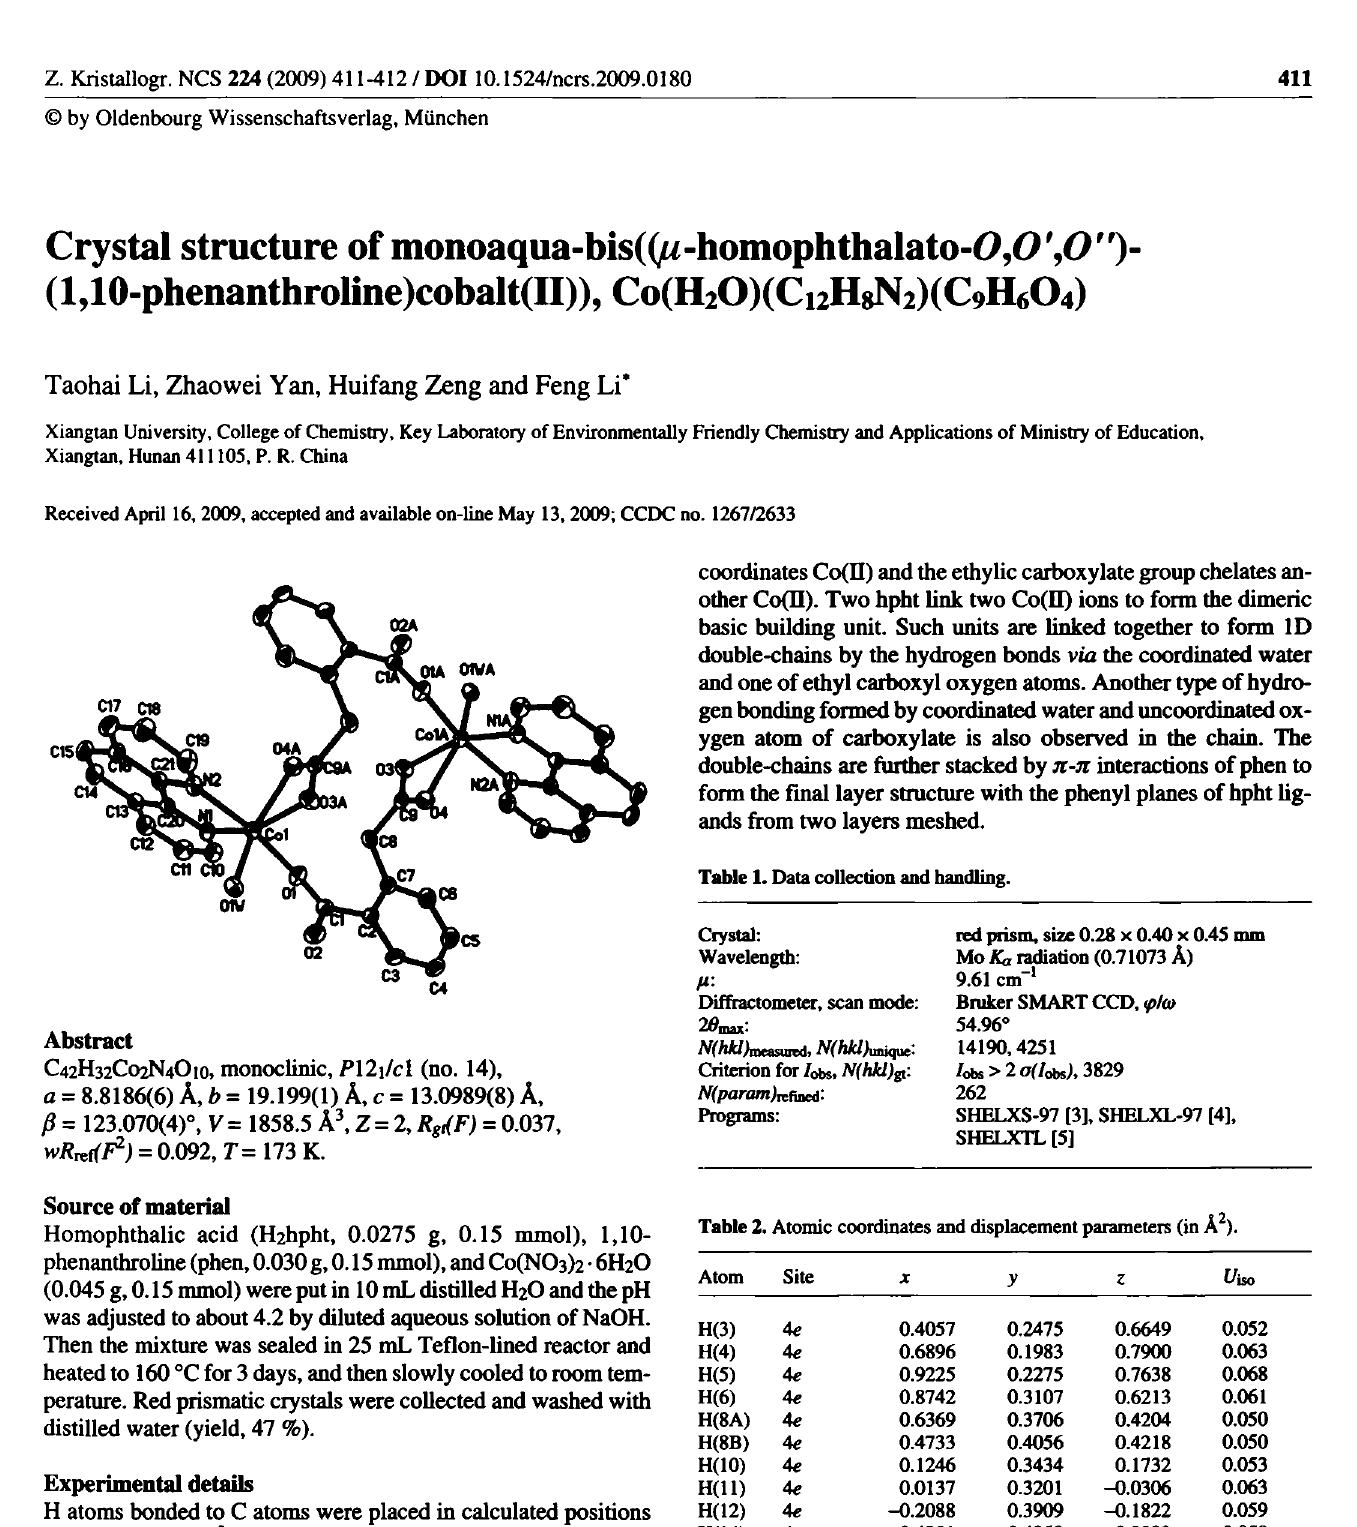
Table 2. Atomic coordinates and displacement parameters (in Â 2